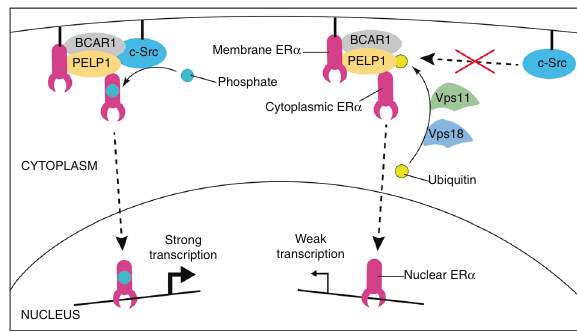
Fig. 8 Proposed mechanism for the regulation of ER α activity by Vps11/18. Note that the purple symbol for ER α represents both the monomer and the dimer of ER